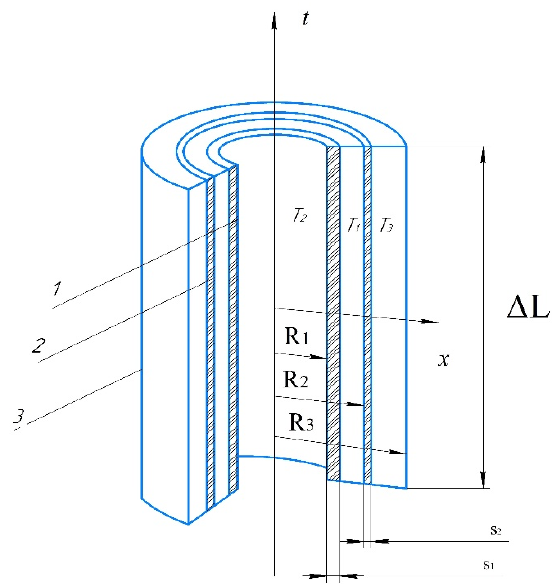
Figure 1. Pipe element during the injection of hot APG into the annular space of the well. 1—Tubing string; 2—Technological pipe (additional pipe); 3—Casing strings; T 1 — Temperature of the injected APJ in the space between the tubing string 1 and technological pipe 2; T 2— Temperature of the fluid inside the tubing string 1; T 3 —Temperature of the fluid in the space between technological pipe 2 and casing strings 3.